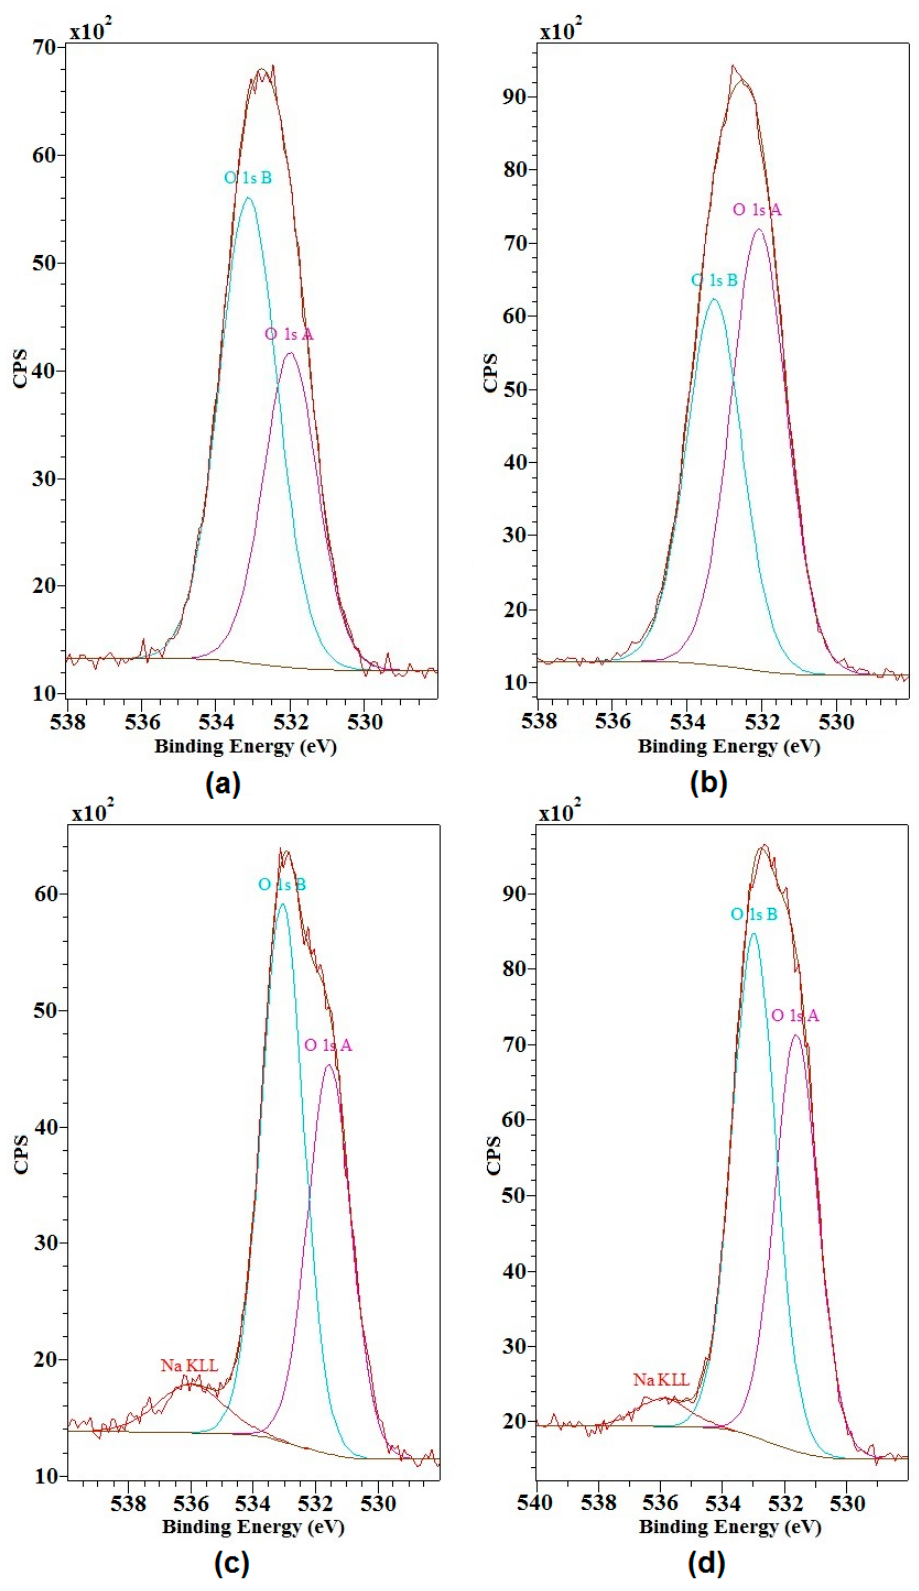
Figure 3. Spectra of the O 1s XPS region for: ( a ) magnesium lignosulfonate (MLS); ( b ) MLS activated using H 2 O 2 ; ( c ) kraft lignin (KL); and ( d ) KL activated using H 2 O 2 .